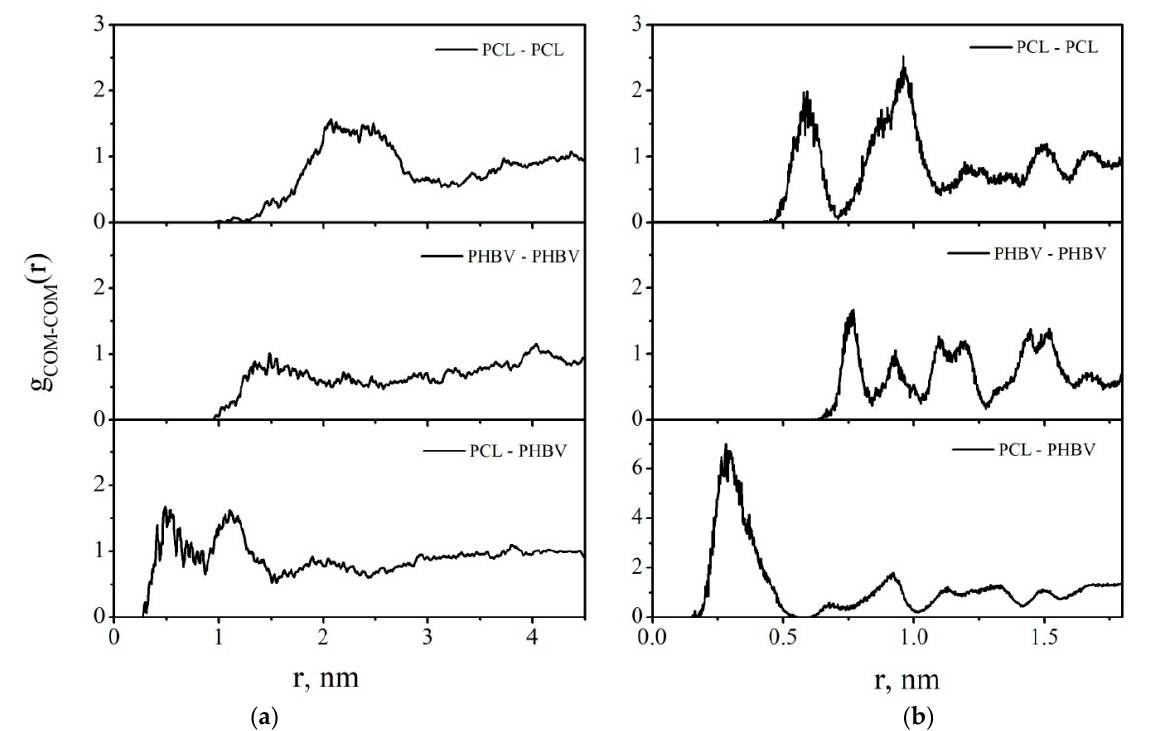
Figure 22. The radial distribution functions between the centers of mass of the polymer macro- molecules in System 2 ( a ) and System 3 ( b ).